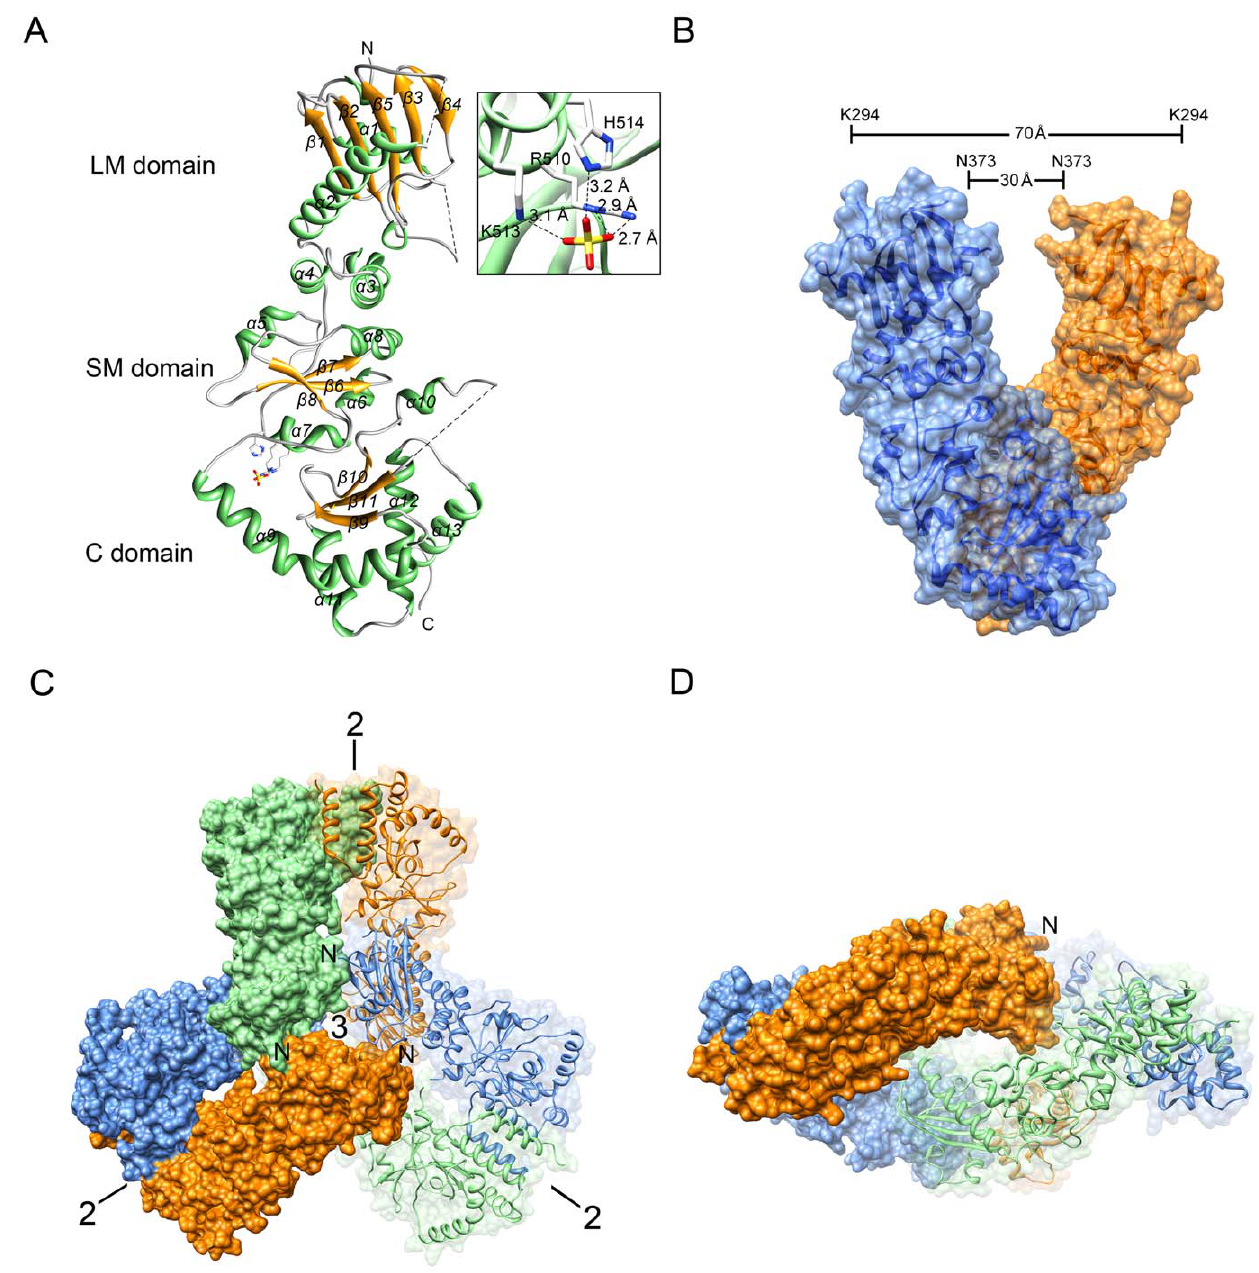
Figure 2. Overall structure of MC-HSP90. (A) Ribbon representation of the MC-HSP90 monomer with a bound sulfate. The large middle (LM), small middle (SM) and C-terminal domains (C) are indicated. The inset figure shows a sulfate bound to R510, K513 and H514. (B) Parallel homodimer of MC-HSP90. Two protomers (blue and orange) extend from its C-terminal dimerization domain with ‘‘Twisted V’’ shape and are shown in ribbon and translucent surface. The inner and outer distances between the open ends are indicated. (C) (D) Top view and side view of the hexameric MC-HSP90 structure. Six MC-HSP90 molecules assemble into a dextral hexamer. The N-termini are located on the top and bottom of the hexamer with 3-fold symmetry. Each protomer is colored in separate colors (blue, green and orange) and half of hexamer is shown with translucent surface.